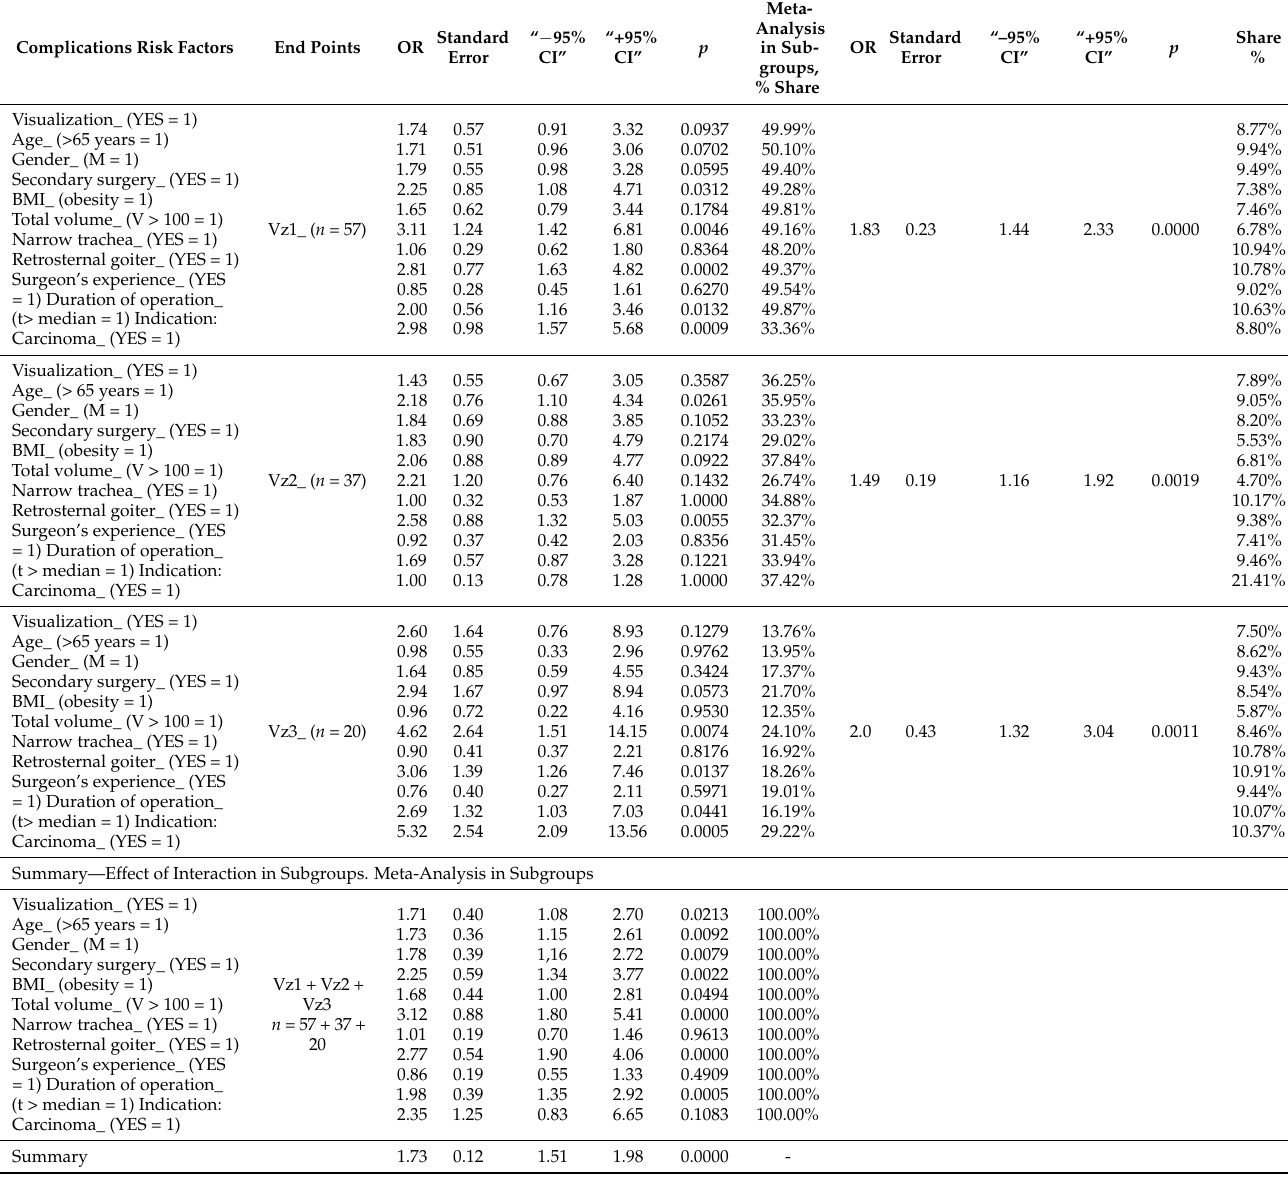
Table 3. Meta-analysis of variable effects according to a scheme taking into account all the possible interactions among the selected subgroups (Vz1, Vz2, Vz3; Vz1 + Vz2 +